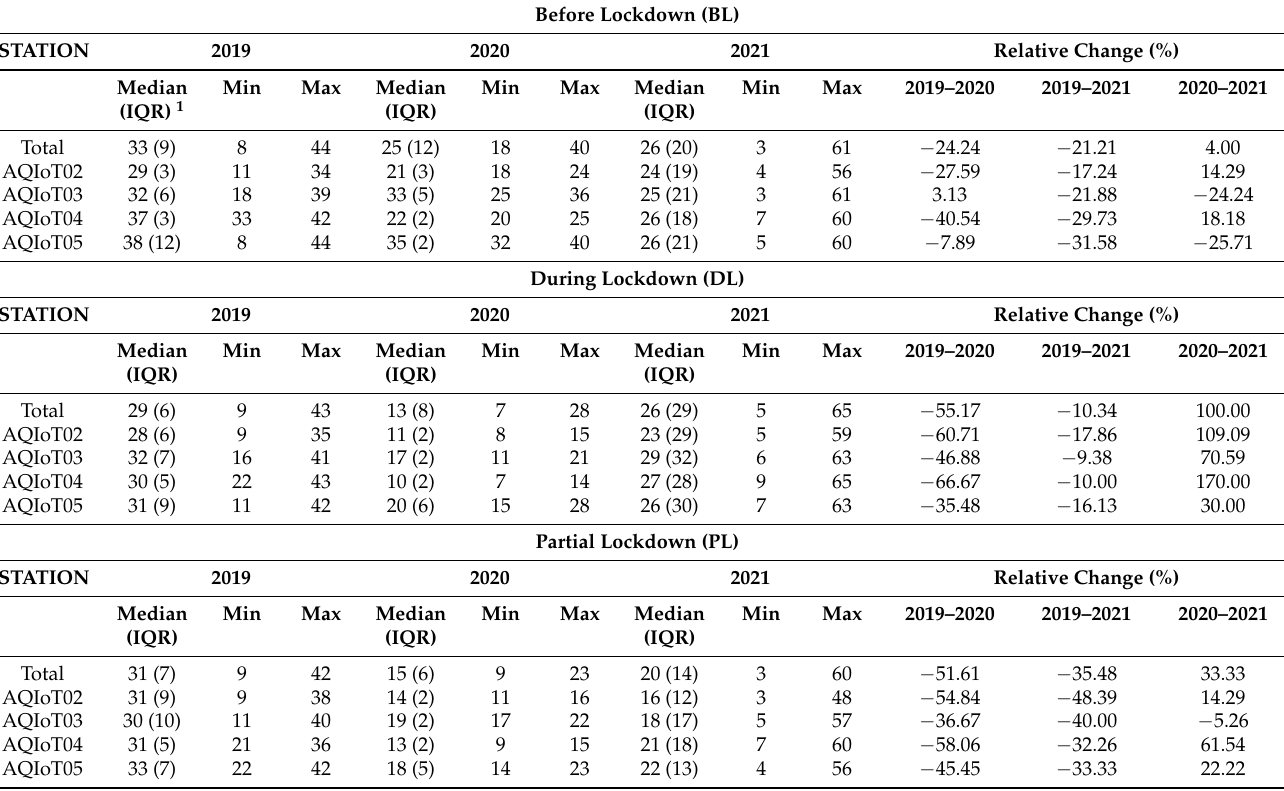
Table 2. Median, IQR, minimum and maximum concentration, and variation of PM 10 ( µ g/m 3 ) in the BL, DL, and PL periods of 2019, 2020, and 2021. Before Lockdown